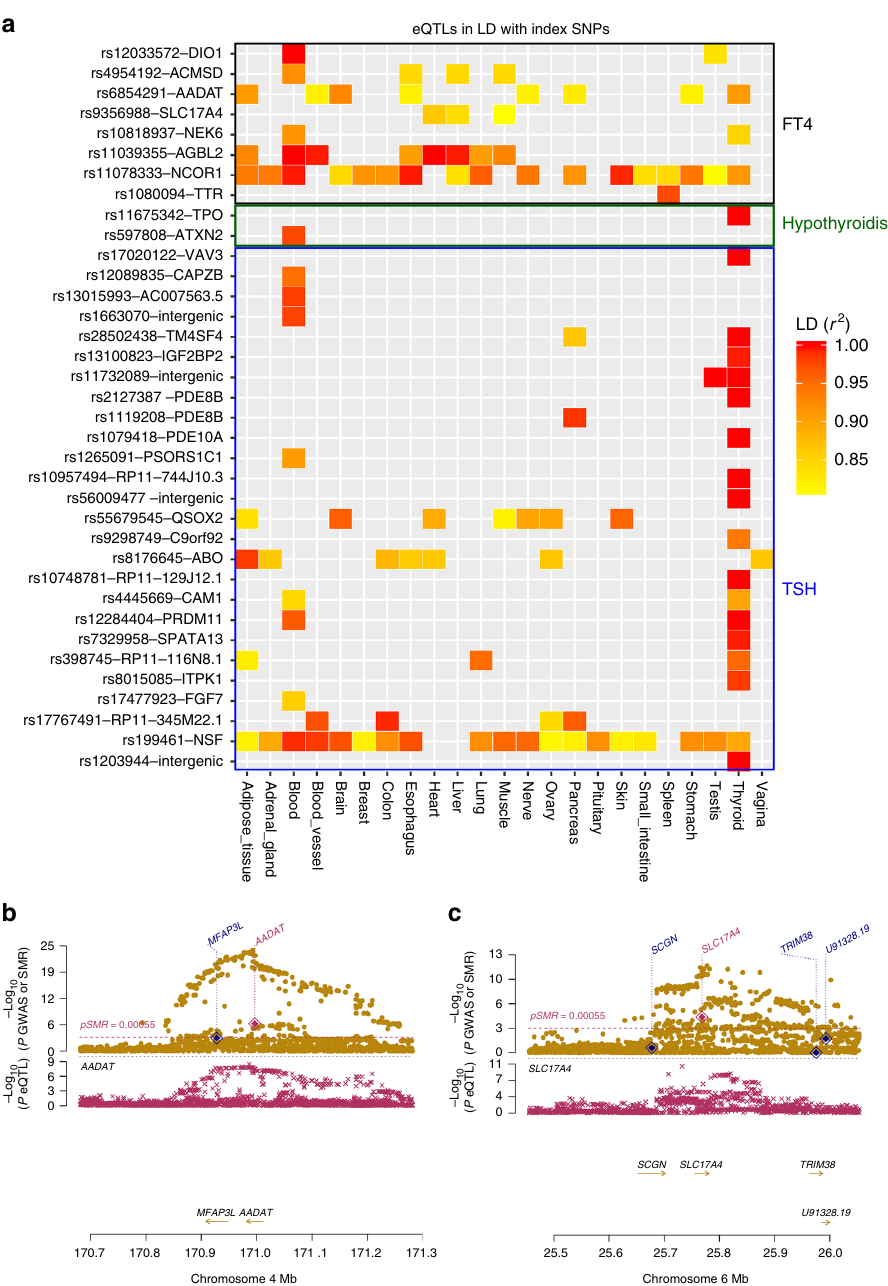
Fig. 2 Impact on gene expression of index SNP. a shows tissues in which an expression QTL (eQTL) was found in LD ( r 2 > 0.8) with FT4, hypothyroidism, and TSH index SNPs. SNPs are ordered according to trait they are associated with and then by genomic position; squares are colored according to the LD between the eQTL and the index variant, as depicted in the legend. When multiple eQTLs were detected in the same tissue, the eQTL with the highest LD is shown. b and c illustrate results of the summary-based Mendelian randomization (SMR) test for FT4 levels and expression QTLs at AADAT and SLC17A4 loci, respectively. The upper box shows the regional association curve with FT4 levels, with level of signi fi cance of the SMR test ( y axis) for each transcript in the locus indicated by a diamond positioned at the center of the transcript. A signi fi cant SMR test indicates an association of the transcript level of the respective genes with the trait. The lower box shows the regional association distribution with changes in expression of the highlighted transcript in pancreas. In both boxes, x axis refers to GRCh37/hg19 genomic